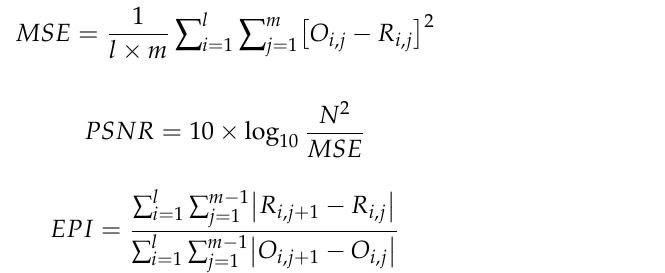
Figure 5. We set this parameter manually for all the experiments conducted.